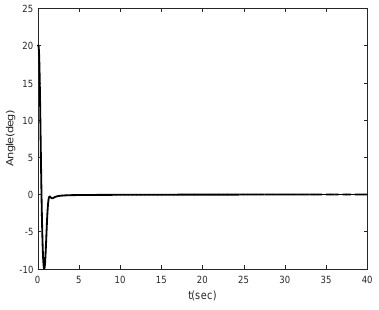
Figure 5. Angle of segway, m = 40 kg, l = 0.75 m.